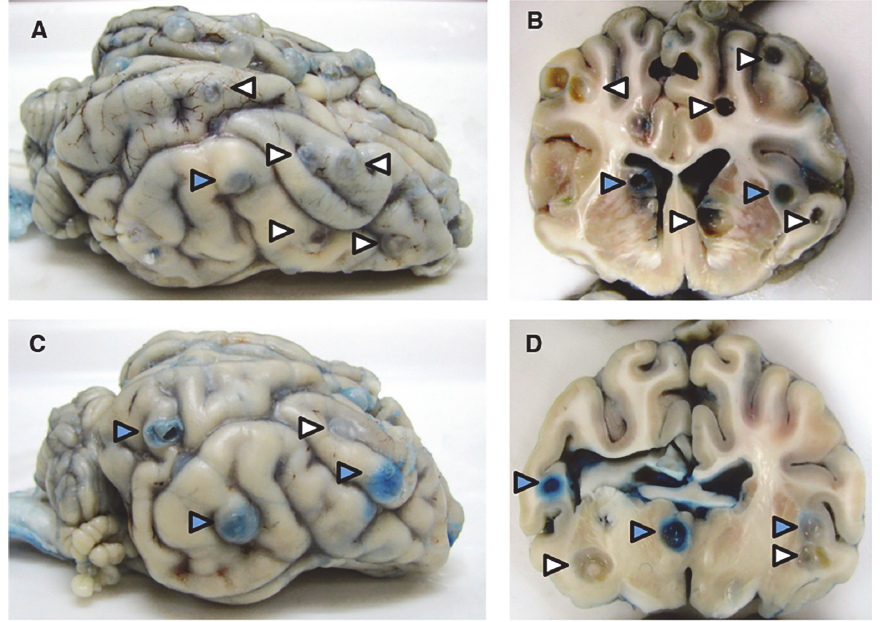
Fig 1. Clear and blue-stained capsules (EB capsules) on the surface and cut surfaces of brains from infected pigs. Photographs of the surface and coronal sections of representative brains from an untreated pig (A and B) and a pig treated with praziquantel 48 h previously (C and D), showing cysts with clear (white arrowheads) and blue capsules (blue arrowheads) visible within the parenchyma and on the